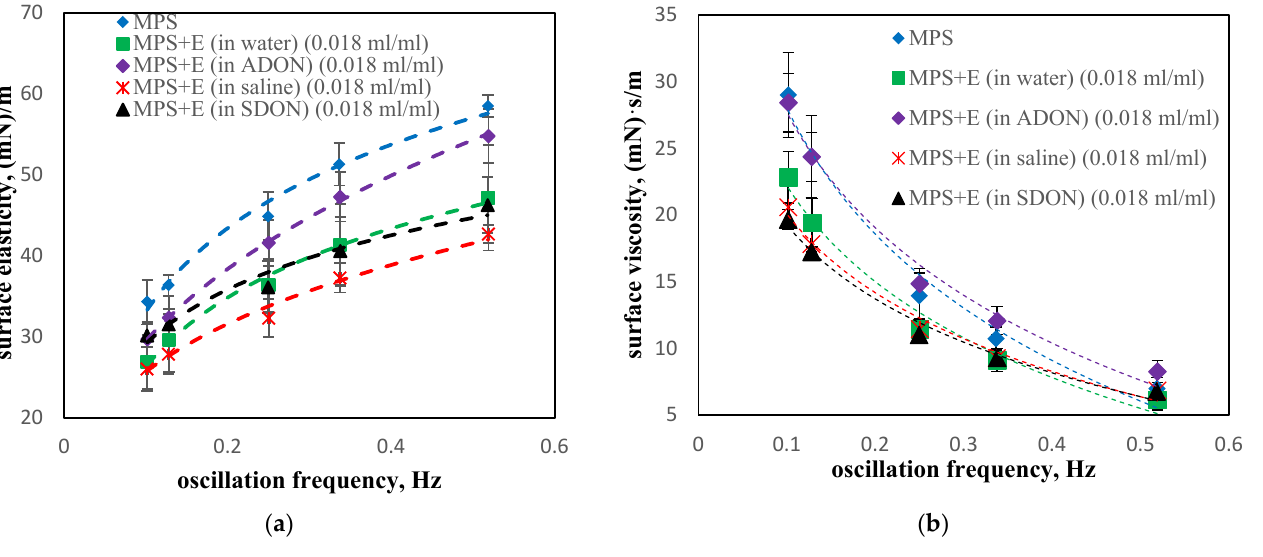
Figure 8. Dilatational surface elasticity ( a ) and viscosity ( b ) of MPS in the presence of the drug with ectoine (E) diluted in water, saline, ADON, or SDON. Similar tendencies to those observed in Figure 8 are noticed for budesonide, B (Figure 9). The addition of budesonide drug in water as well as in saline reduces the dilatational elasticity of MPS. The presence of NBs (in ADON/SDON—violet and black markers in Figure 9a) has no significant influence on the elasticity values compared to MPS + B (in water or saline—green and red markers). These results clearly show that changes in the dilatational rheological parameters are caused by the drug formulation rather than by NBs.